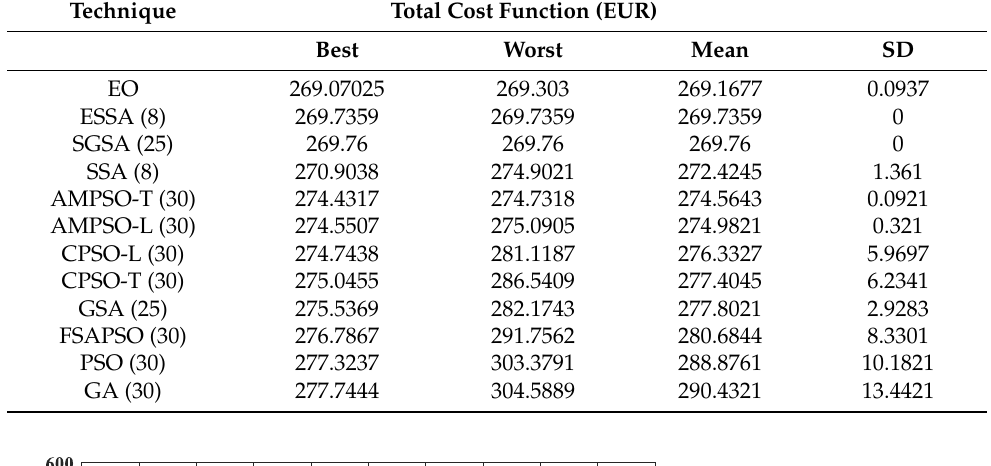
Table 3. Comparison of the EM problem based on Case 1.